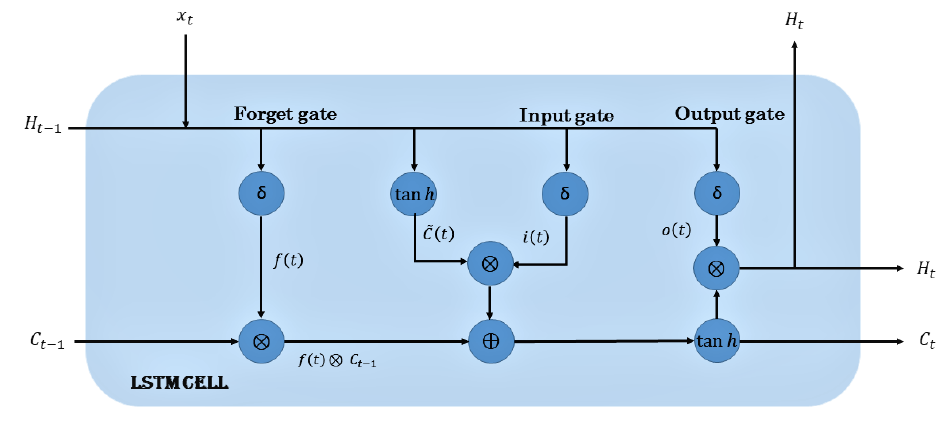
Figure 4. The architecture of LSTM